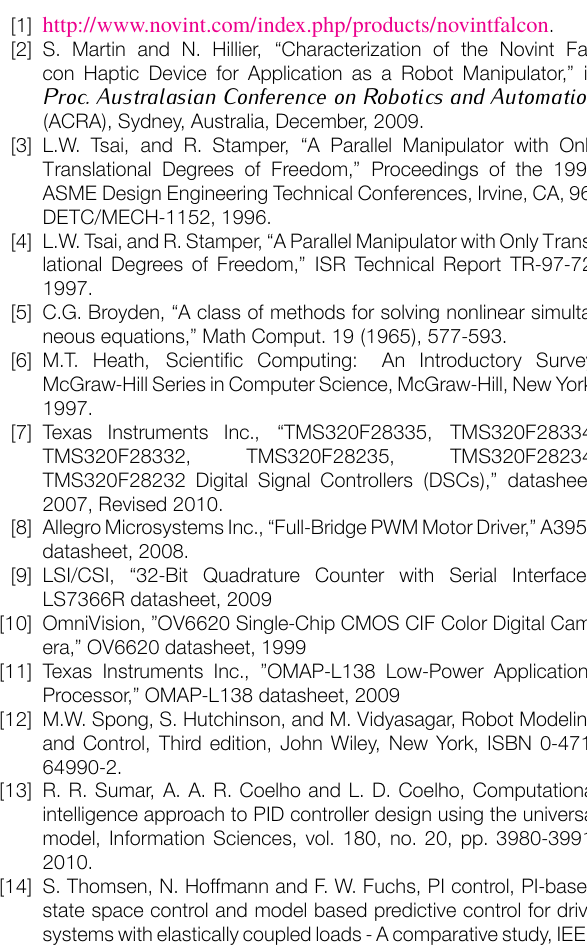
Figure 31: Tuned step response for feedback‐linearized P‐D control Figure 30. Experimental, tuned step response for feedback-linearized PD con- trol.